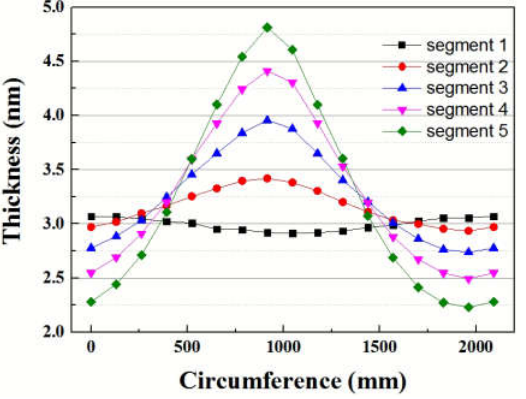
Figure 5. Film thickness distribution curve for different segments from one to